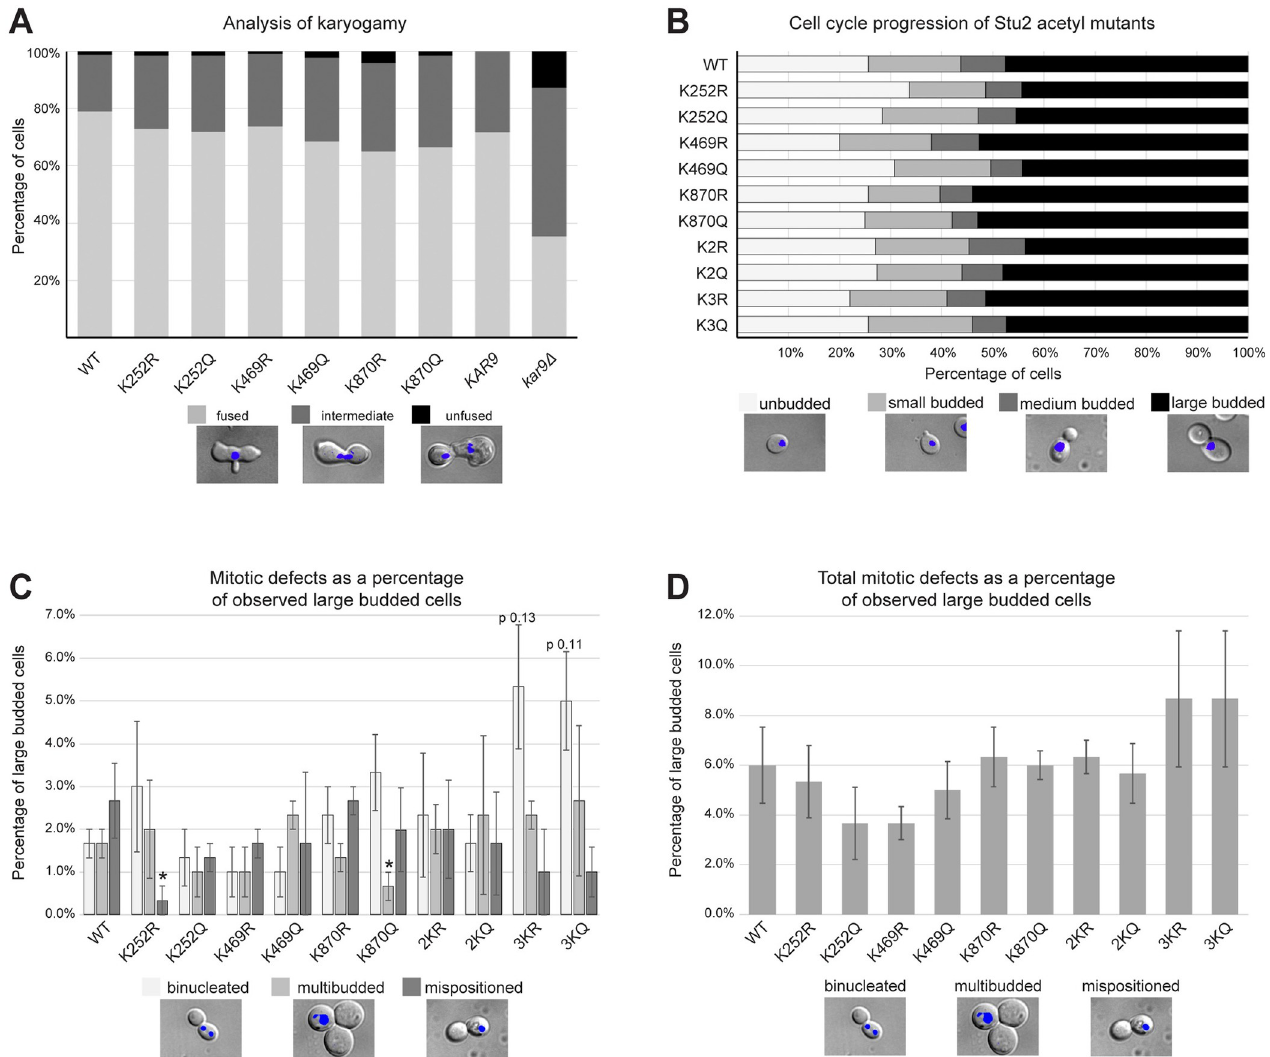
Fig 6. Minor nuclear positioning defects were observed in large-budded cells of yeast expressing the 3KR and 3KQ Stu2 acetyl mutations. (A) MAT a or MAT α mating type yeast with plasmids expressing STU2 (yRM11379 and yRM11368), Stu2-K252R (yRM11930 and yRM11892), Stu2-K252Q (yRM11934 and yRM11898), Stu2-K469R (yRM11375 and yRM11362), Stu2-K469Q (yRM11377 and yRM11366), Stu2-K870R (yRM11938 and yRM11912), Stu2-K870Q (yRM11940 and yRM11922) in a stu2 Δ background were tested in a karyogamy assay as described in [31]. In addition, yeast containing a genomic copy of KAR9 (yRM299 and yRM301) or a genomic deletion of KAR9 (yRM393 and yRM396) were assayed to represent moderate karyogamy defects. (B) Logarithmically growing yeast with plasmids expressing STU2 (yRM12358), K252R (yRM12360), K469R (12361), K870R (12362), 2KR (yRM12363), 3KR (yRM12364), K252Q (yRM12365), K469Q (yRM12366), K870Q (yRM12367), 2KQ (yRM12368), and 3KQ (yRM12369) in a stu2 Δ background were evaluated for the percentage of unbudded, small budded, medium budded and large budded cells in the population. (C) Large-budded cells of yeast were DAPI stained and further examined for binucleate, multi-budded, and cell polarity defects. Bar graphs displayed as mean ± SEM derived from 3 counts of 100 large budded cells; � p < 0.1. 3KR and 3KQ exhibiting binucleation defects were close, but did not pass t-testing thresholds for marginal significance with p values of 0.13 and 0.11 respectively. (D) The aggregate of mitotic defects across Stu2 acetylation mutants are graphed for comparison to a WT control.